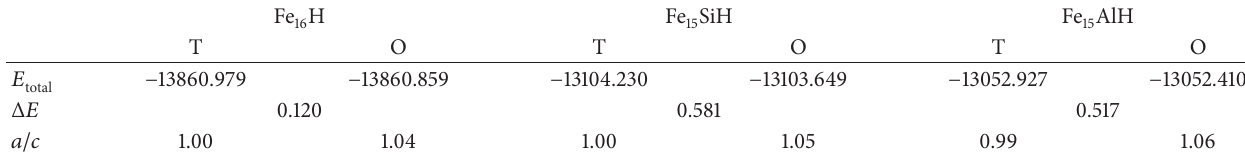
Table 3: Calculated results of total energy ( 𝐸 distortion ( 𝑎/𝑐 ) in supercells, eV.